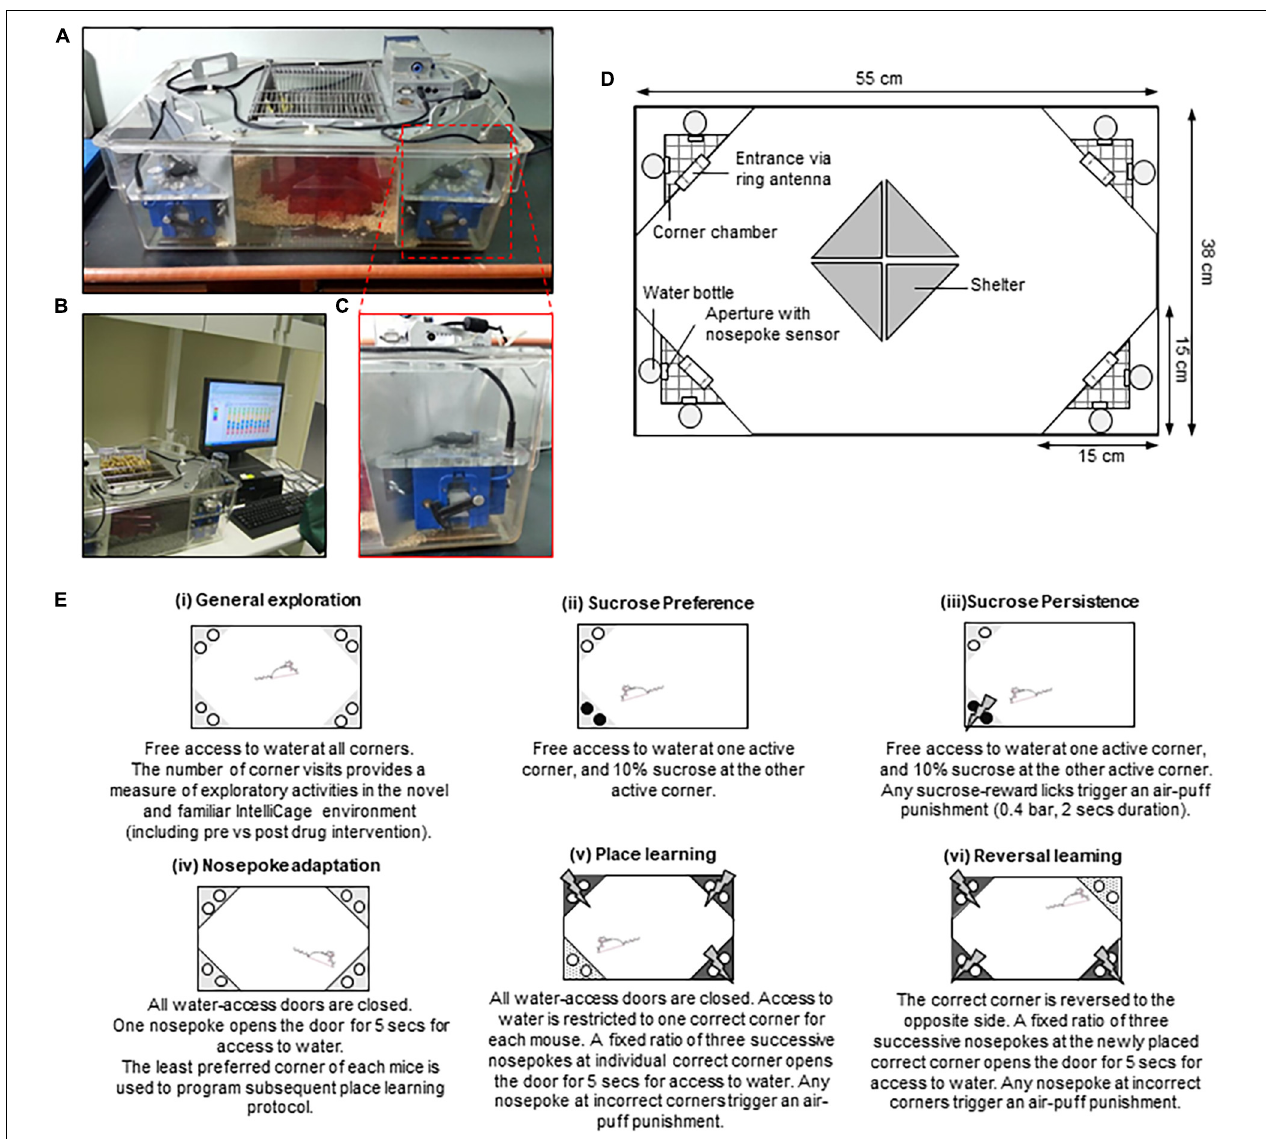
FIGURE 1 | An overview of the IntelliCage system. (A) The IntelliCage apparatus. (B) The IntelliCage apparatus is connected to a computer-based software used to design various behavioral protocols, as well as to measure and analyze mice behavioral patterns. (C) The motorized doors at each IntelliCage corner chamber which control access to water bottle nipples. (D) Schematic illustration of the IntelliCage. (E) Summary of IntelliCage parameters modified from Iman et al.